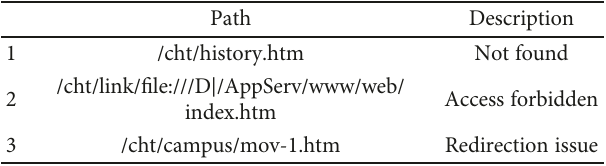
Figure 7: Test result of the blanket mode (request distribution). Table 3: Test result of the blanket mode (errors and exceptions).